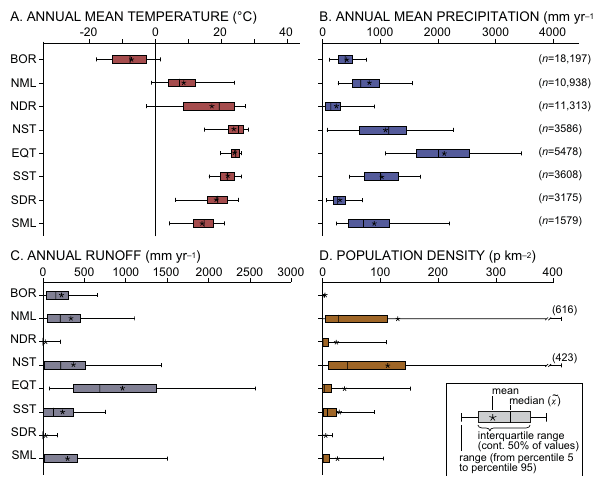
Fig. 3. Distribution of average annual cell characteristics in hydrobelts presented with box plot graphs. (a) annual mean temperature; (b) annual mean precipitation; (c) annual run- off; and (d) population density. BOR=boreal, NML=northern mid-latitude, NDR=northern dry, NST=northern subtropical, EQT=equatorial belts and SML, SDR, SST their southern ana- logues (see Fig. 2 for their spatial distributions). Ranges correspond to the 5–95 percentile distribution. Note: outliers are not